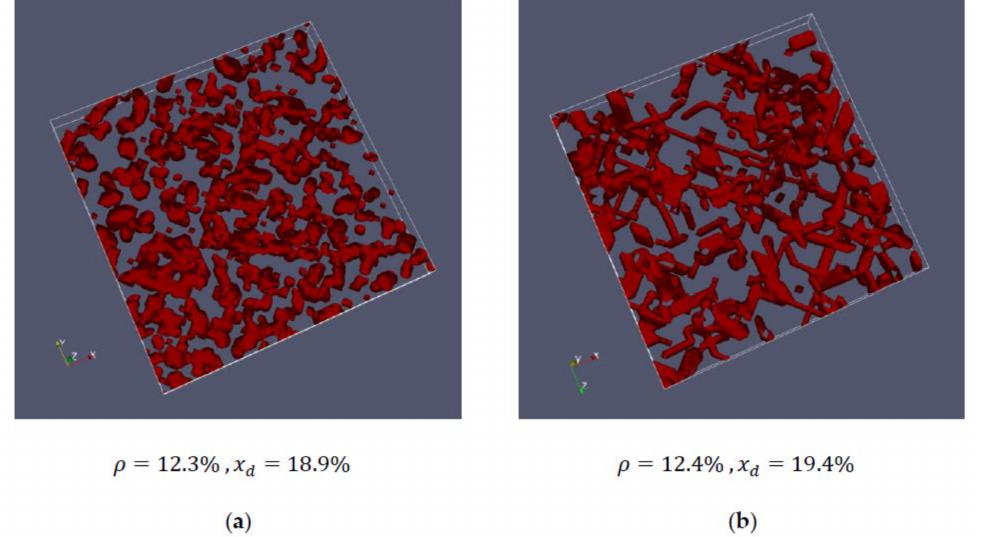
Figure 4. Comparison of a 10 layer actin network: ( a ) measured network of cell #1 ( b ) artificially generated network #1.